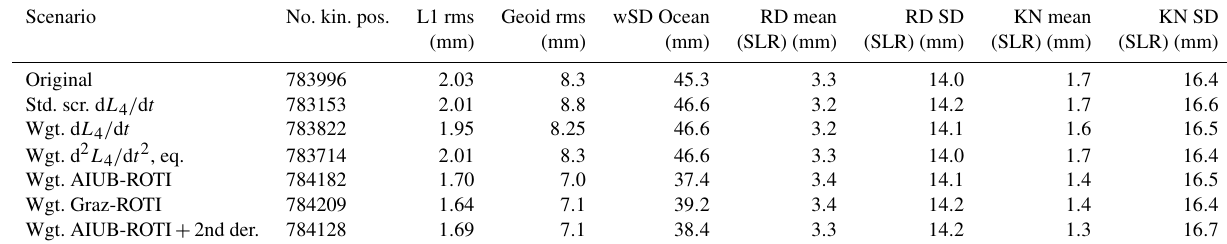
Table 2. Statistics and SLR residuals for Swarm A, June 2016. Scenario